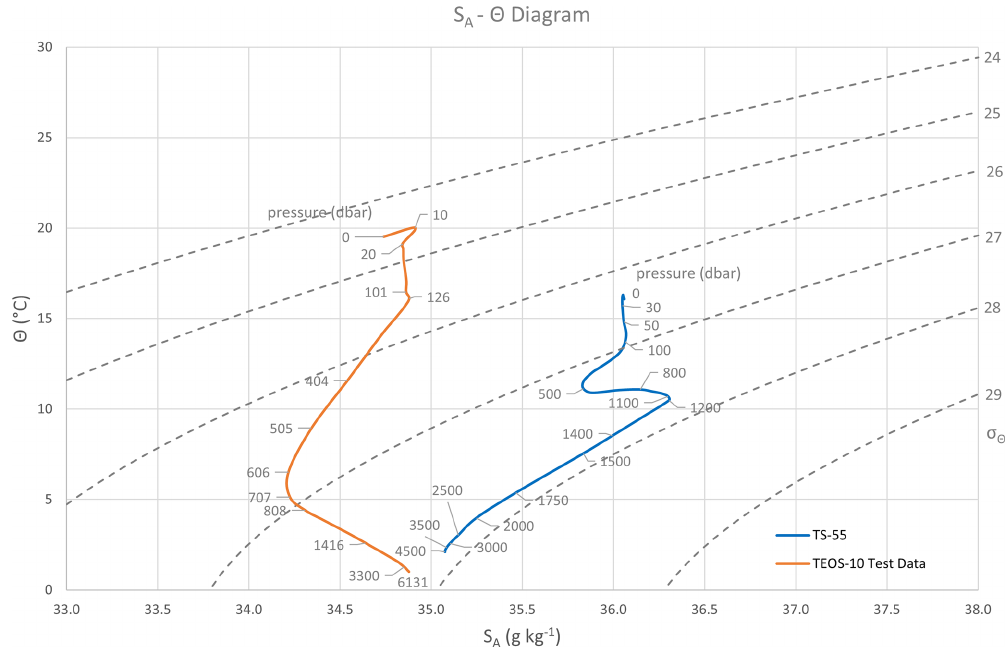
Figure 5. Absolute Salinity ( S A ) –Conservative Temperature ( (cid:50)) diagrams. Data are from the TEOS-10 Test Data (NW Pacific) and TS-55 tab (NE Atlantic off the Iberian Peninsula). Pressure values are obtained dynamically from the data, and the density field ( σ (cid:50) ) is computed from data included in the spreadsheet template.